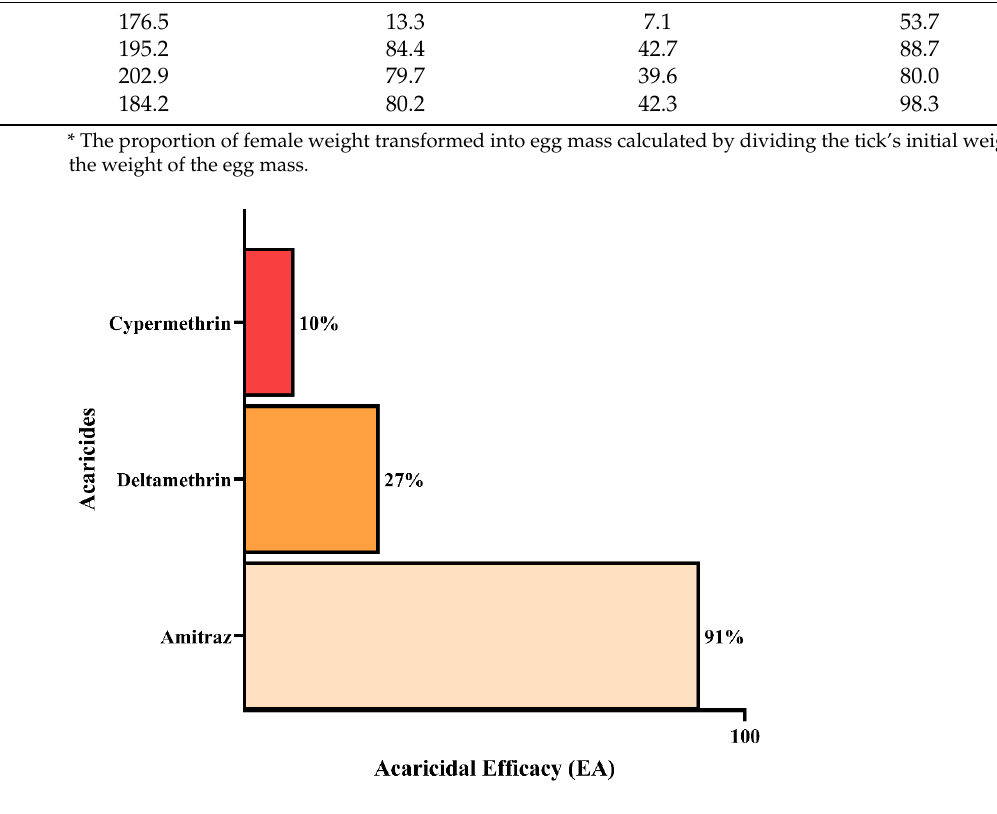
Figure 3. Acaricidal efficacy of Amitraz, Cypermethrin, and Deltamethrin against R.microplus en- gorged females.